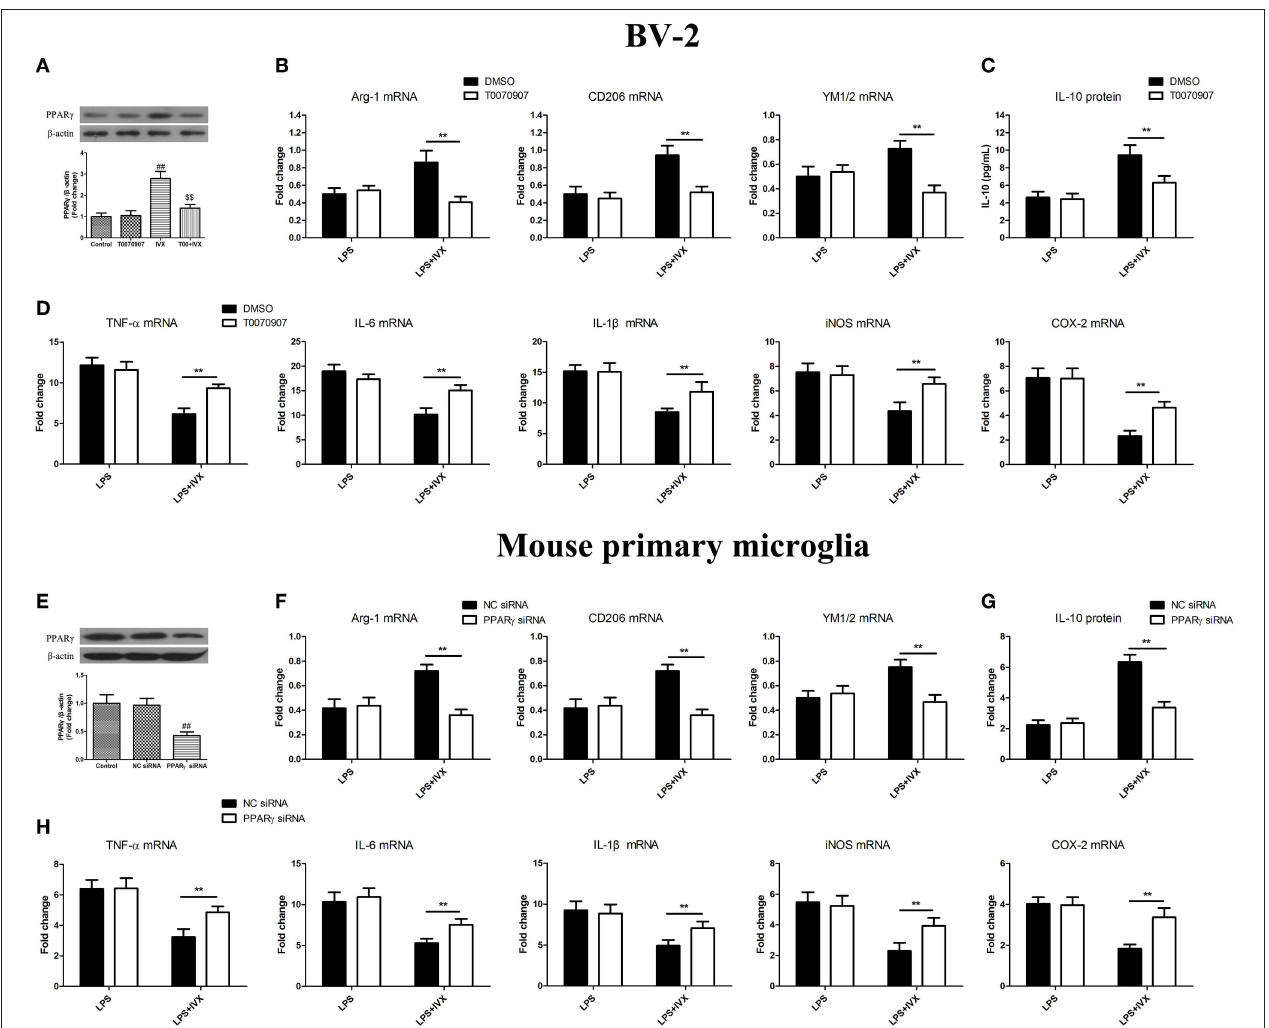
FIGURE 3 | PPAR γ activation is involved in IVX-mediated microglial polarization in LPS- induced BV-2 cells and mouse primary microglia. (A) After treatment with T0070907 (an inhibitor of PPAR γ ) for 2h and PPAR γ siRNA for 24h and then IVX for 2h in BV-2 cells and mouse primary microglia, the protein expression of PPAR γ was measured with Western blotting. Following pretreatment with 5 µ M T0070907 for 2h and PPAR γ siRNA for 24h, cells were treated with IVX (200 µ g/mL) for 2h and then stimulated with LPS (100ng/mL) for 6h. (E) The protein expression of PPAR γ was detected via Western blotting. (B,F) The mRNA expression of M2 microglial markers (Arg-1, CD206, and YM1/2) were detected via RT-PCR. (D,H) The mRNA expression of M1 microglial markers (TNF- α , IL-6, IL-1 β , iNOS, and COX-2) were detected via RT-PCR. Pretreatment with 5 µ M T0070907 for 2h and PPAR γ siRNA for 24h, cells were treated with IVX (200 µ g/mL) for 2h and then stimulated with LPS (100ng/mL) for 24h. (C,G) The release of IL-10 was measured with ELISA. The experiments were conducted in triplicate and repeated at least three times. Values are expressed as mean ± SEM ( n = 4 in each group). ## p < 0.01, vs. control group; $$ p < 0.01, vs. IVX group; ** p < 0.01, T0070907 or PPAR γ siRNA + LPS + IVX group vs. LPS + IVX